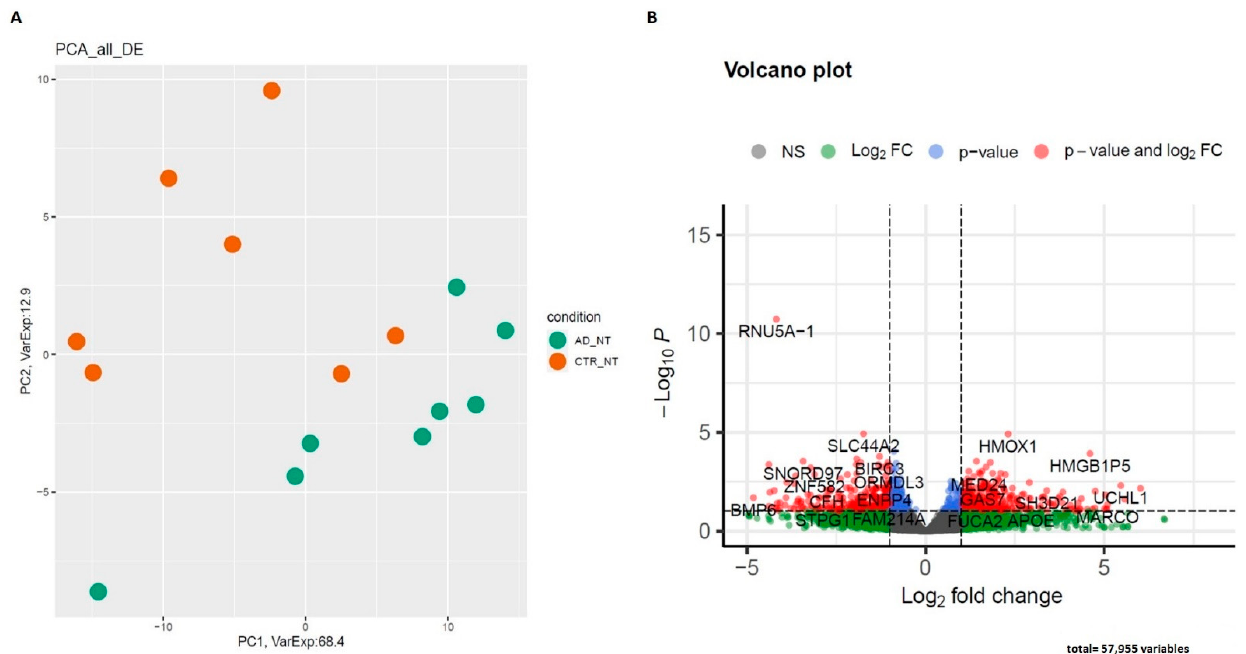
Figure 4. ( A ) PCA of differentially expressed genes. All comparisons are given between AD compared to CTR. ( B ) Volcano plot of differentially expressed genes between AD and CTR (AD_NT N° = 8 and CTR_NT N° = 7). Table 2. Most deregulated genes identified between AD-NT and CTR-NT and their suggested roles in